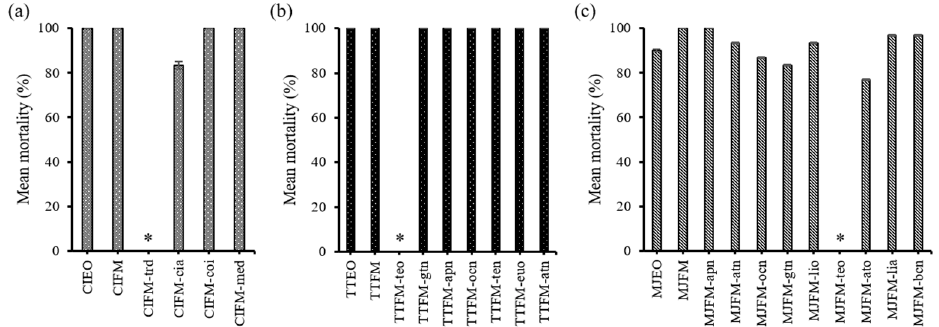
Figure 3. Compound elimination assay via contact and residual application: ( a ) cinnamon oil at LD 95 of 0.22 mg/cm 2 ; ( b ) tea tree oil at LD 95 of 0.37 mg/cm 2 ; ( c ) marjoram oil at LD 95 of 0.37 mg/cm 2 against S. zeamais adults. Asterisks denote significant differences at p = 0.05. (apn: (+)- α -pinene, atn: α -terpinene, ato: α -terpineol, bcn: β -caryophyllene, cia: cinnamyl acetate, coi: coumarin, euo: eucalyptol, gtn: γ -terpinene, lia: linalyl acetate, lio: linalool, med: ( E )-4-methoxycinnamaldehyde, ocn: o-cymene, ten: terpinolene, teo: (–)-terpinen-4-ol, and trd: trans -cinnamaldehyde).